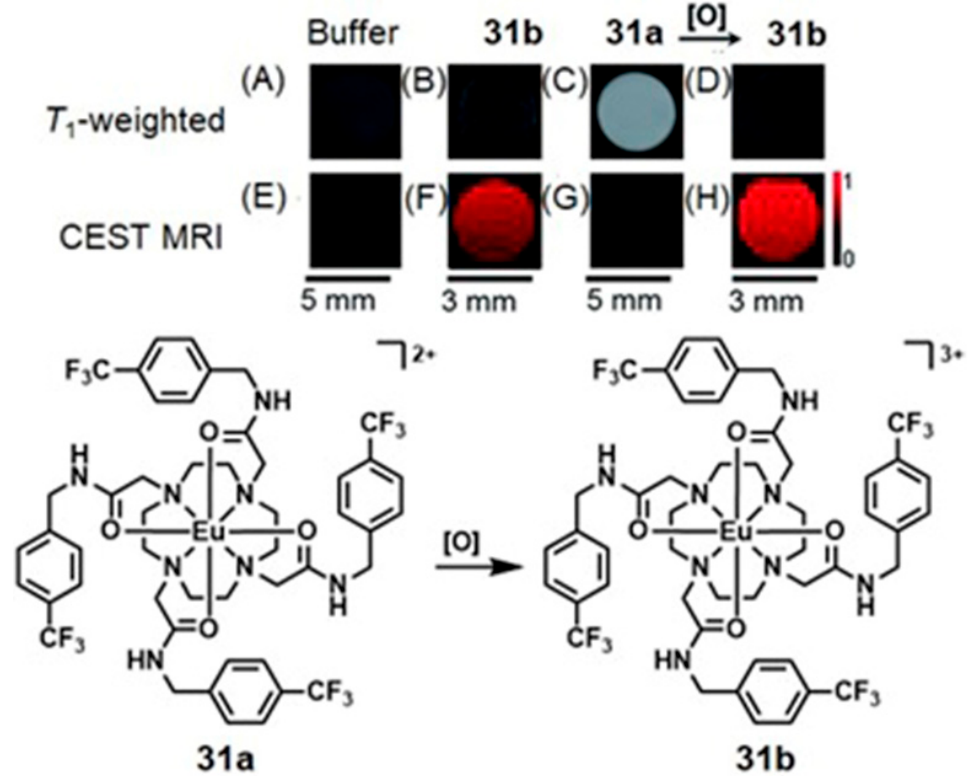
Figure 69. MRI of solutions of samples in aqueous 3-morpholinopropane-1-sulfonic acid buffer (20 mM, pH 7.0) in glass (3 mm) or plastic tubes (5 mm). Scale bars correspond to the three images in the column above each bar. (Top row) T 1 -weighted MRI images of solutions of ( A ) aqueous 3-morpholinopropane-1-sulfonic acid buffer (20 mM, pH 7.0); ( B ) 31b (3.5 mM); ( C ) 31a (3.5 mM); and ( D ) 31b after oxidation of 31a (3.5 mM). (Bottom row) CEST MRI images of ( E ) aqueous 3-morpholinopropane-1-sulfonic acid buffer (20 mM, pH 7.0); ( F ) 31b (3.5 mM); ( G ) 31a (3.5 mM); and ( H ) 31b after oxidation of 31a (3.5 mM). The scale bar on the right of (h) represents signal intensity for all CEST MRI images in Figure 69. Adapted with permission of the Royal Society of Chemistry, from Fluorinated Eu II -based multimodal contrast agent for temperature- and redox-responsive magnetic resonance imaging, Basal, L. A.; Bailey, M. D.; Romero, J.; Ali, M. M.; Kurenbekova, L.; Yustein, J. T.; Pautler, R. G.; Allen, M. J. 8 , 12, 2017 ; permission conveyed through Copyright Clearance Center, Inc. [398].